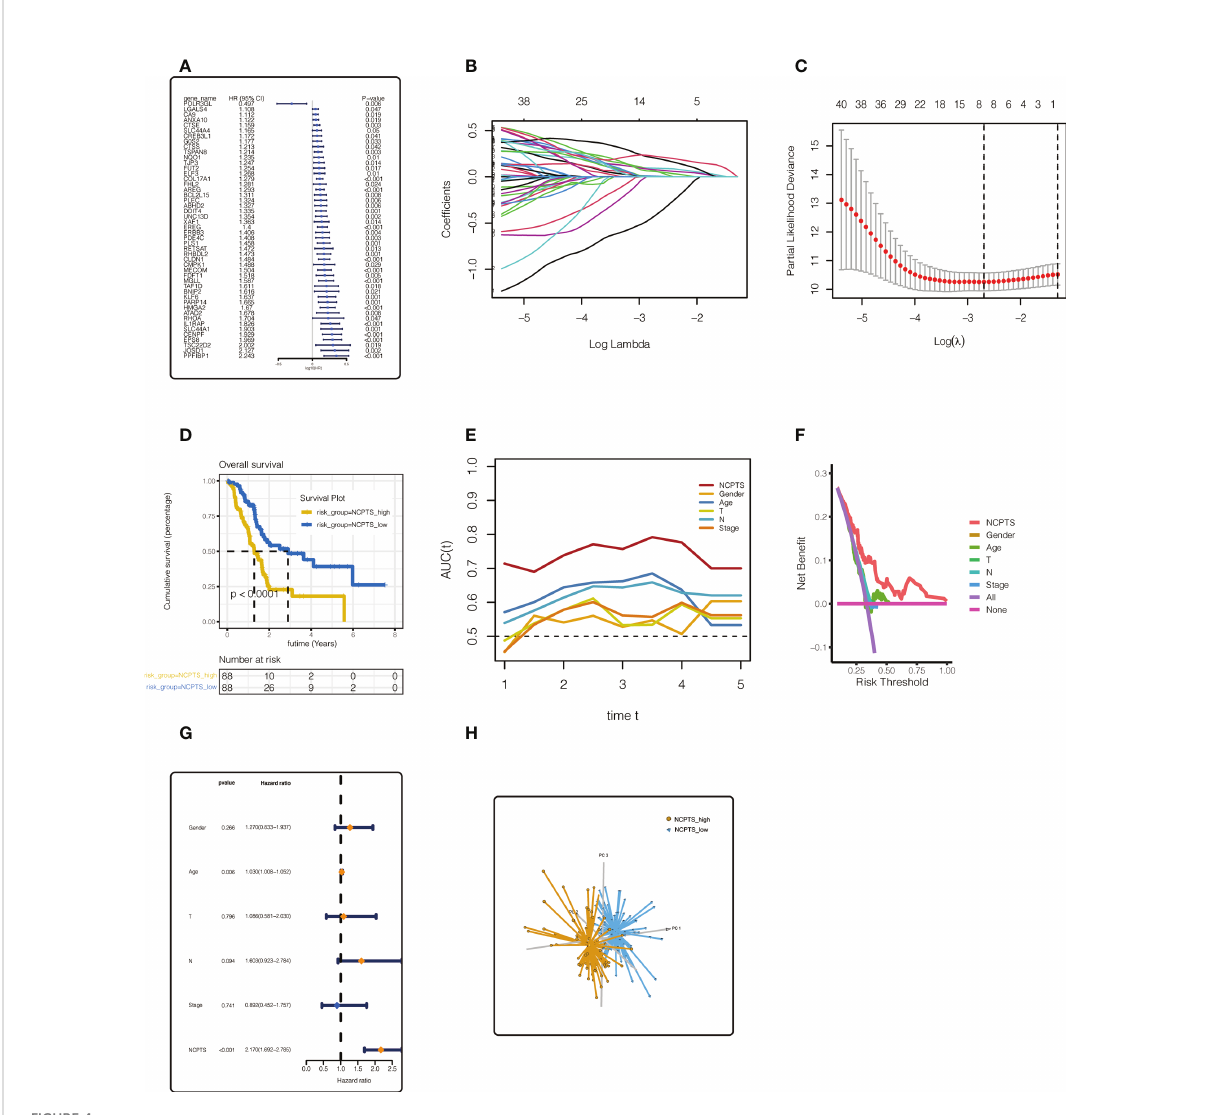
FIGURE 4 Establishment of the prognostic model in TCGA cohort. (A) Univariate Cox analysis of 805 most related genes. 48 necroptosis genes were identi fi ed by univariate Cox analysis of 805 necroptosis genes in TCGA and PA-AU cohort. (B, C) LASSO regression analysis. The model constructed by 8 genes is fi nally obtained. (D) Survival anaylsis. Patients with NCPTS_high had a poor prognosis (P <0.001). (E) ROC curve analysis. The AUC of model value NCPTS was maintained at about 0.75. (F) Decision curve analysis. (G) Multivariate Cox analysis. NCPTS was an independent prognostic factor for pancreatic cancer patients. (H) Principal component analysis (PCA). The model can distinguish patients into NCPTS_high and NCPTS_low groups